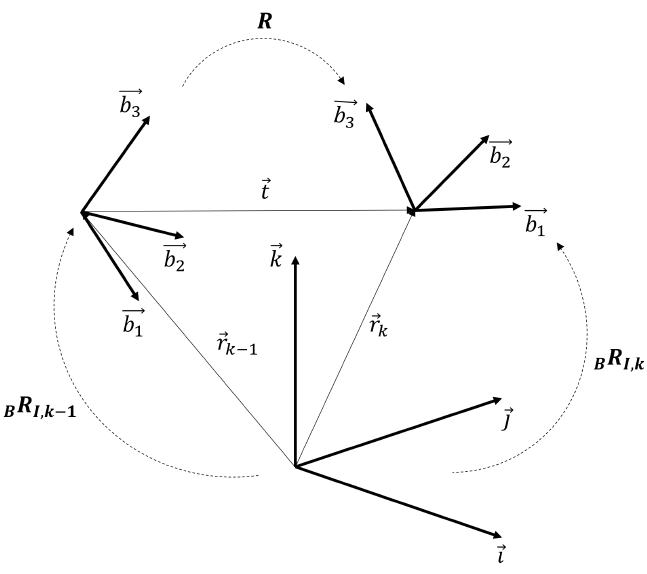
Figure 5. Frame-to-frame visual odometry reference